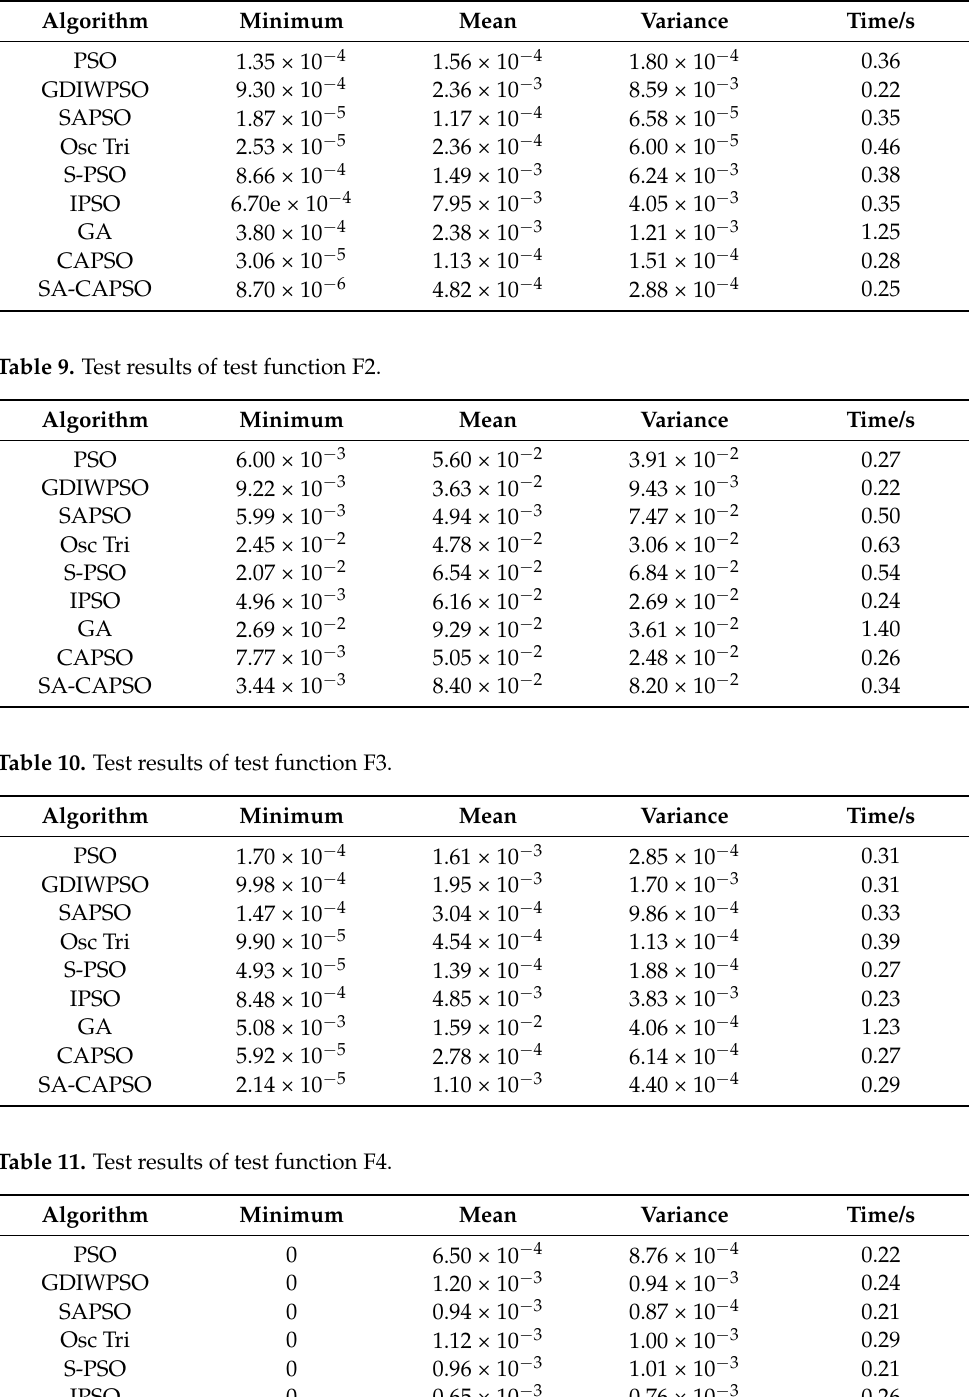
Table 8. Test results of test function F1.